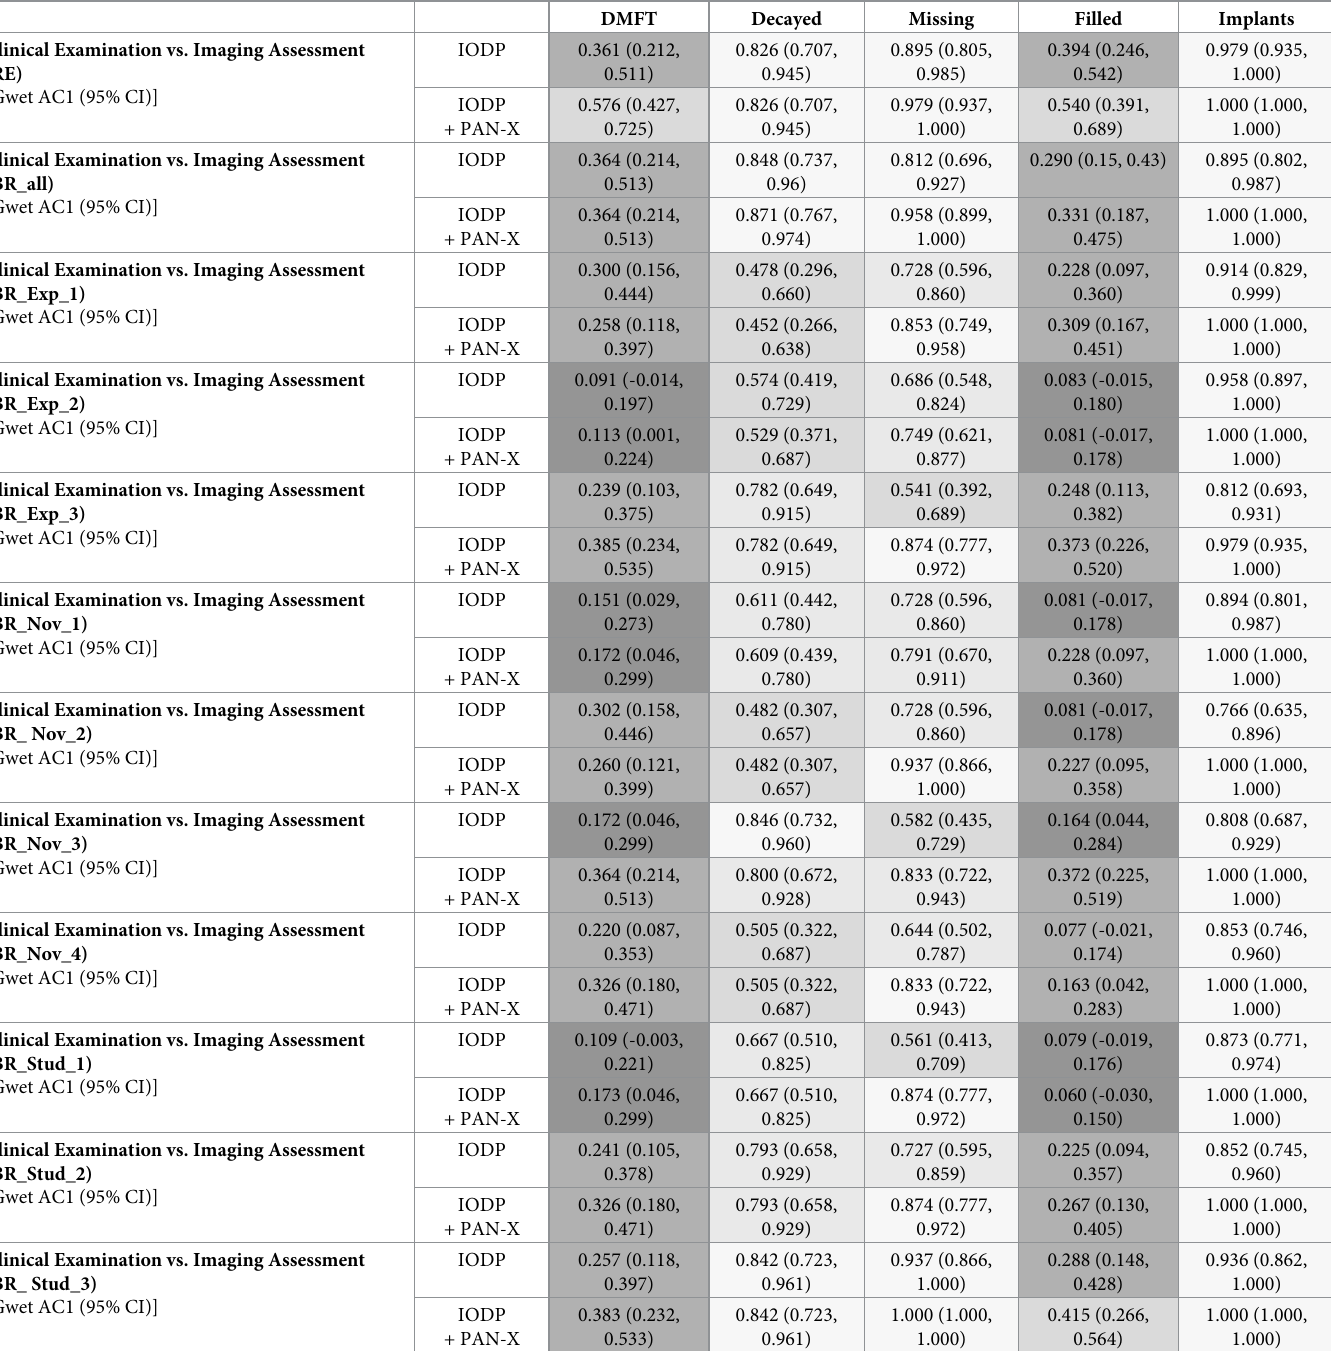
Table 3. Agreement of IODP/IODP+PAN-X assessment and clinical diagnosis. DMFT Decayed Missing Filled